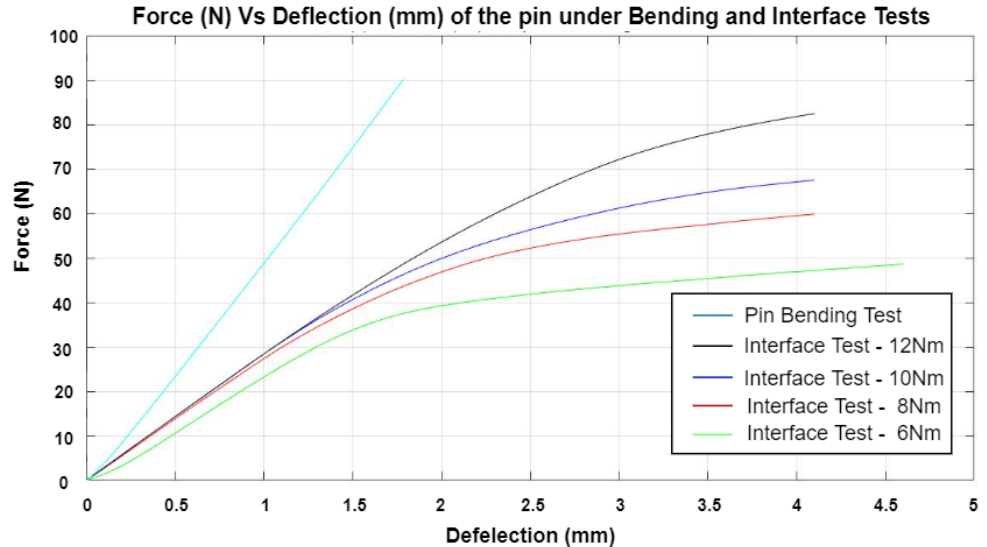
Figure 14. Results of the pin bending (Blue) and interface tests. Tightening load 6 Nm (Green), 8 Nm (Red), 10 Nm (Dark Blue), and 12 Nm